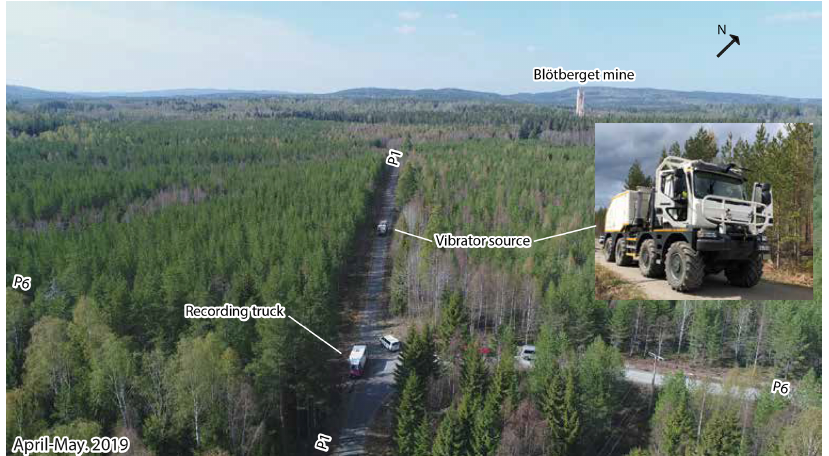
Figure 3. Field photos from the 3D seismic survey (April–May 2019) in the Blötberget mine. The survey was conducted using the 32t vibrator of TU Bergakademie Freiberg, with 1266 receivers, 414 of which were cabled (part of P1 and entire P3). The cabled profiles were used for live data quality control and sweep parameter tests. Earlier reported 2D profiles (years 2015 and 2016) were also along P1. Photos by Alireza Malehmir.